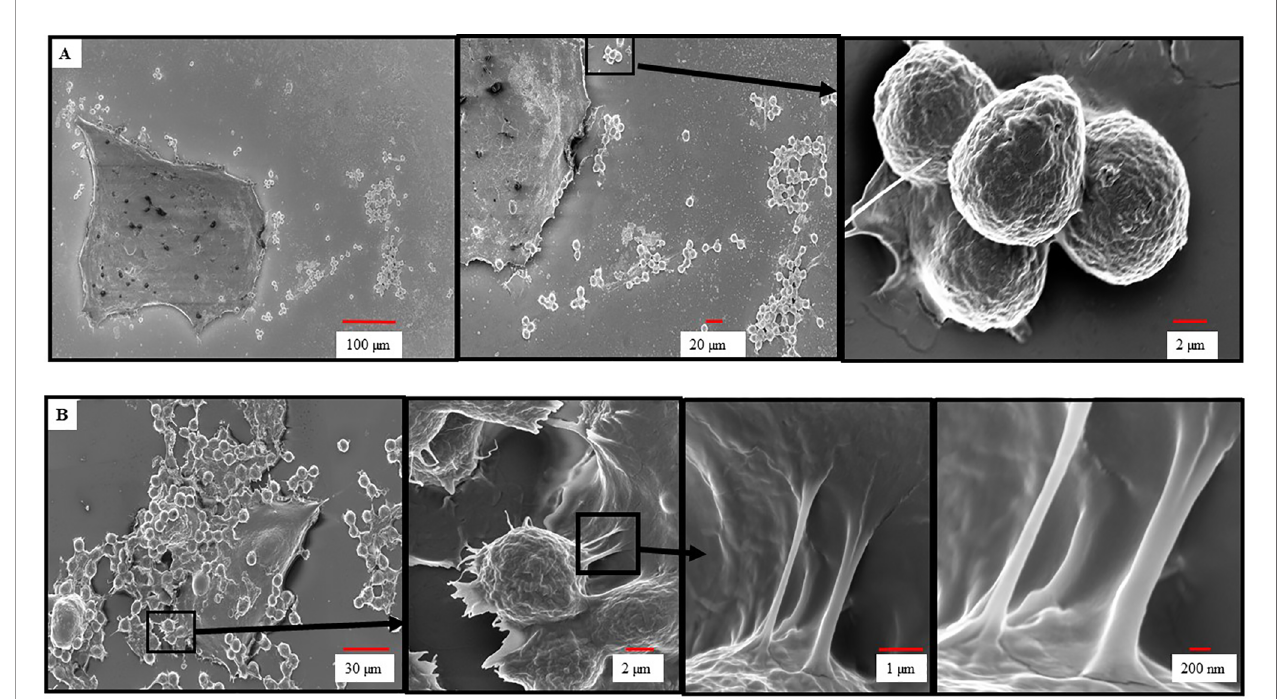
FIGURE 2 | Scanning electron microscopy of ADMC and BC cell interactions. ADMC (1.5×10 5 ) were sensitized with 1 m g/ml of non-speci fi c IgE (A) or anti-HER2/ neu IgE (B) for 1 h, washed, and added to HER2/ neu + BT474-1261 cells (about 60% con fl uence) and incubated for 24 h at 37°C. Cells were collected, supernatants removed for b -hexosaminidase release, and samples fi xed for SEM as described above. Arrows denote magni fi ed